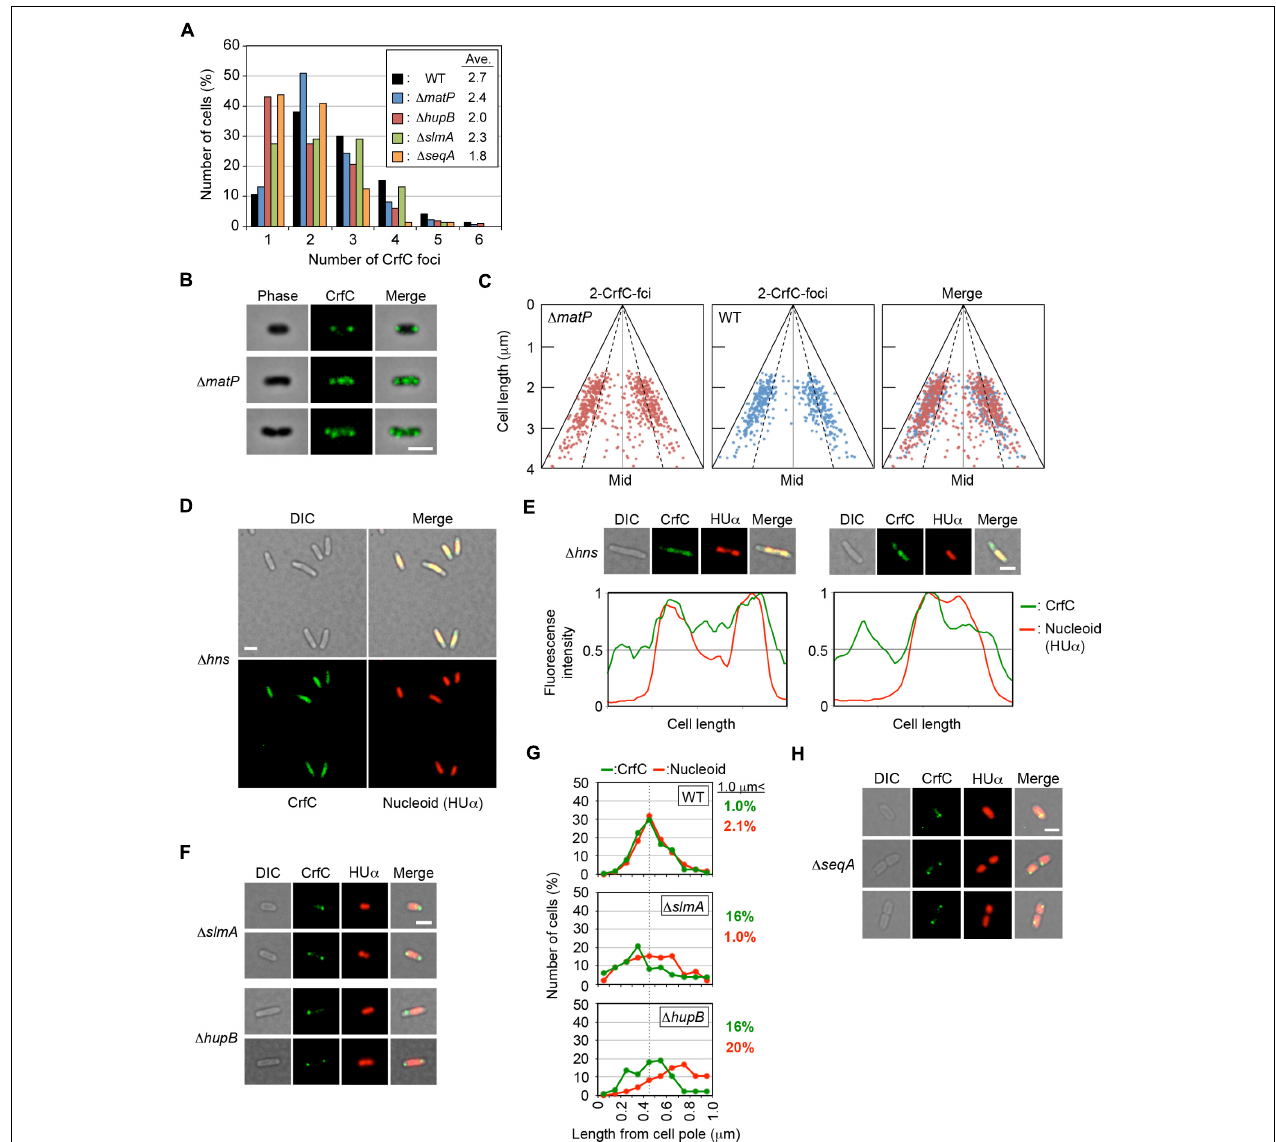
FIGURE 7 | Effect of deletion of nucleoid-associated protein on CrfC localization. (A) Percentages of MECS133-K (WT; wild-type control), MECS145 ( (cid:49) matP ), MECS179 ( (cid:49) hupB ), MECS177 ( (cid:49) slmA ), and MECS193 ( (cid:49) seqA ) cells containing the indicated number of CrfC foci. In total, 665 (WT), 663 ( (cid:49) matP ), 102 ( (cid:49) hupB ), 76 ( (cid:49) slmA ), and 71 ( (cid:49) seqA ) cells were analyzed. (B) Representative images of fluorescent foci and the morphology of MECS145 ( (cid:49) matP ) cells. Cells containing two or four CrfC foci are shown. Scale bar is 2 µ m. (C) Subcellular positioning of CrfC in the cell-polar are in MECS91-K (wild-type matP ) and MECS145 ( (cid:49) matP ) cells. Mid, mid-cell. (D) Images of fluorescent foci and the morphology of MECS171 ( (cid:49) hns ) cells incubated at 30 ◦ C. Scale bar is 2 µ m. (E) Representative images of MECS171 ( (cid:49) hns ) cells incubated at 30 ◦ C. Scale bar is 2 µ m. Normalized fluorescence intensities of CrfC (green line) and nucleoid (red line) along the length of the cell are shown below each image. (F) Representative images of fluorescent foci and the morphologies of MECS177 ( (cid:49) slmA ) and MECS179 ( (cid:49) hupB ) cells. Scale bar is 2 µ m. (G) Distance from the cell pole to the pole-area CrfC or the nucleoid pole in MECS133-K (WT), MECS177 ( (cid:49) slmA ), and MECS179 ( (cid:49) hupB ) cells. NP, nucleoid pole. Broken line: peak position from the graph of wild-type cells. (H) Representative images of fluorescent foci and the morphologies of MECS193 ( (cid:49) seqA ) cells. Scale bar is 2 µ